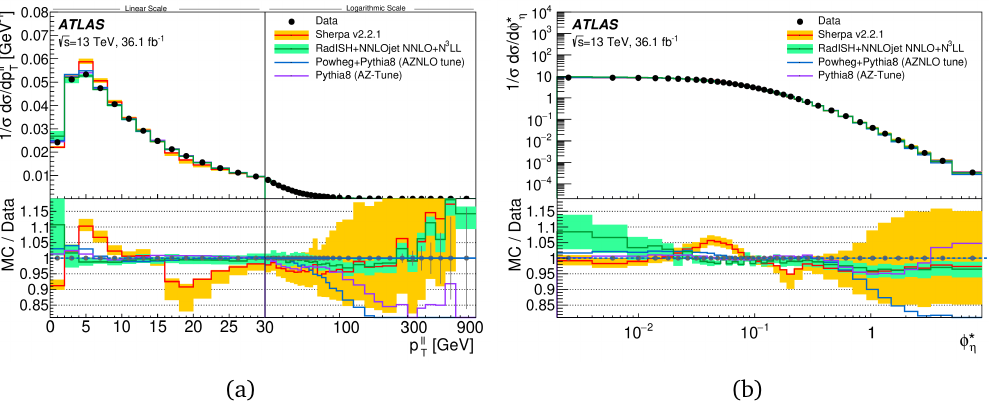
Figure 3: Comparison of normalized (a) p ll ious computations. The uncertainties of Sherpa and Radish predictions are presented by error bands. Plots are taken from [ 3 ]